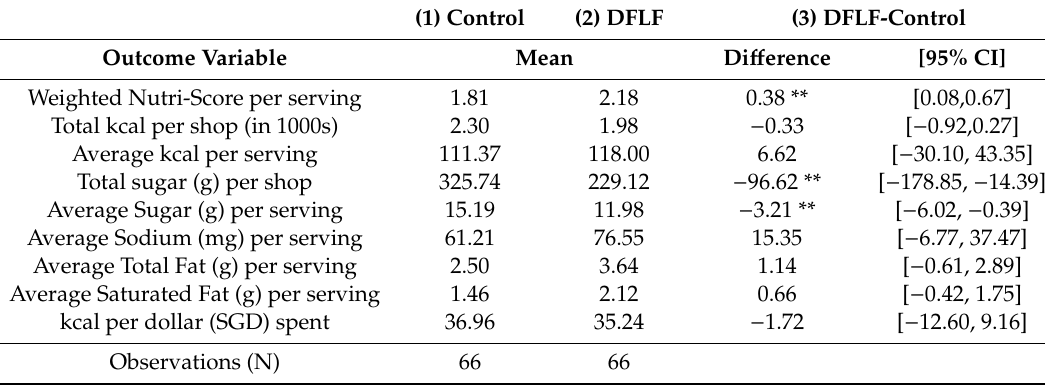
Table 3. The e ff ects of the dynamic food labels with real-time feedback (DFLF) on the nutritional quality of purchased beverages.